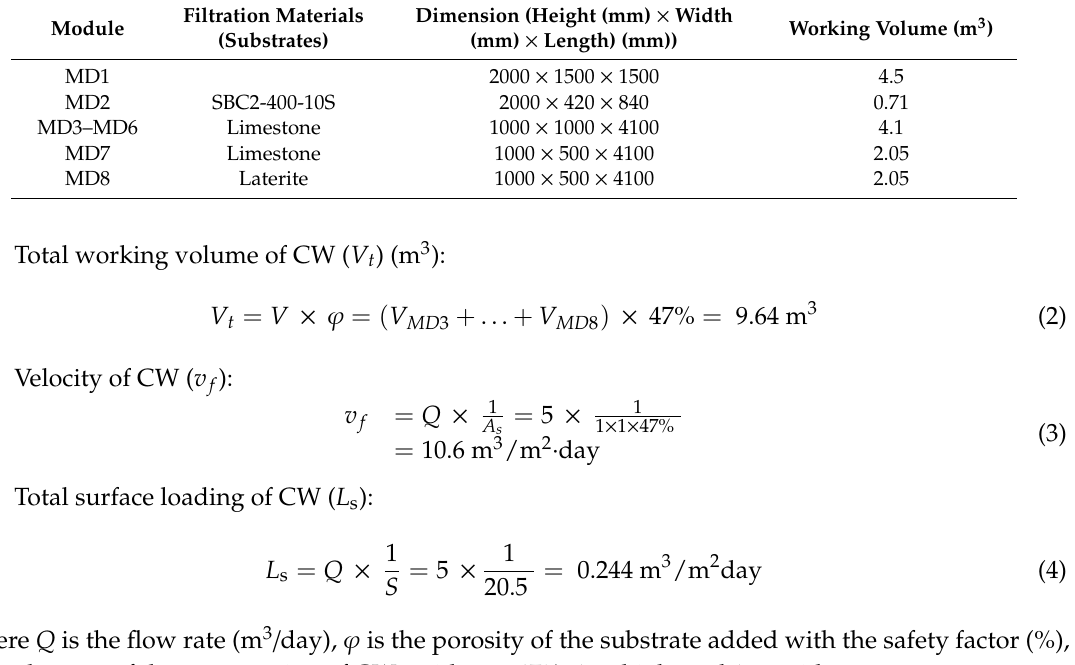
Table 2. Size parameters of modules of the treatment system. MD1: settling tank, MD2: adsorbent